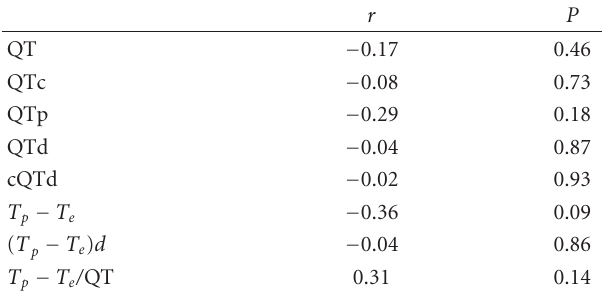
Table 4: Correlation and statistical significance of the ECG para- meters to cardiac T2 ∗